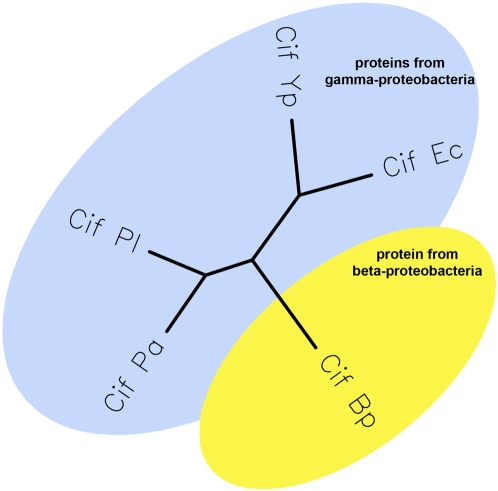
Phylogenetic relationship between CifEc, CifYp, CifBp, CifPl and CifPa.A multiple alignment of the protein sequences (see Fig. 3A) was used to obtain the unrooted tree with Phylip's DrawTree software.